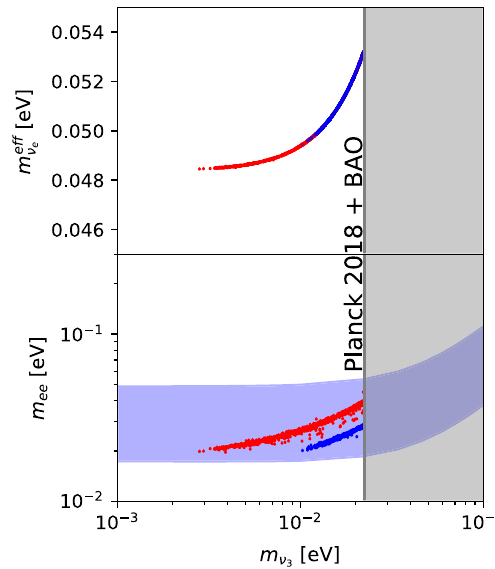
Fig. 3 Effective neutrino masses as a function of the lightest neutrino mass for beta decay experiments (top) and neutrinoless double beta decay experiment (bottom). On both plots, we show the Planck+BAO (cid:2) 0 . 022 eV, and on the bottom we also bound translated to m ν , m ν 3 3 show the standard 95% CL band for m ee [48] for comparison. For red (blue) points, θ 23 resides in the first (second)